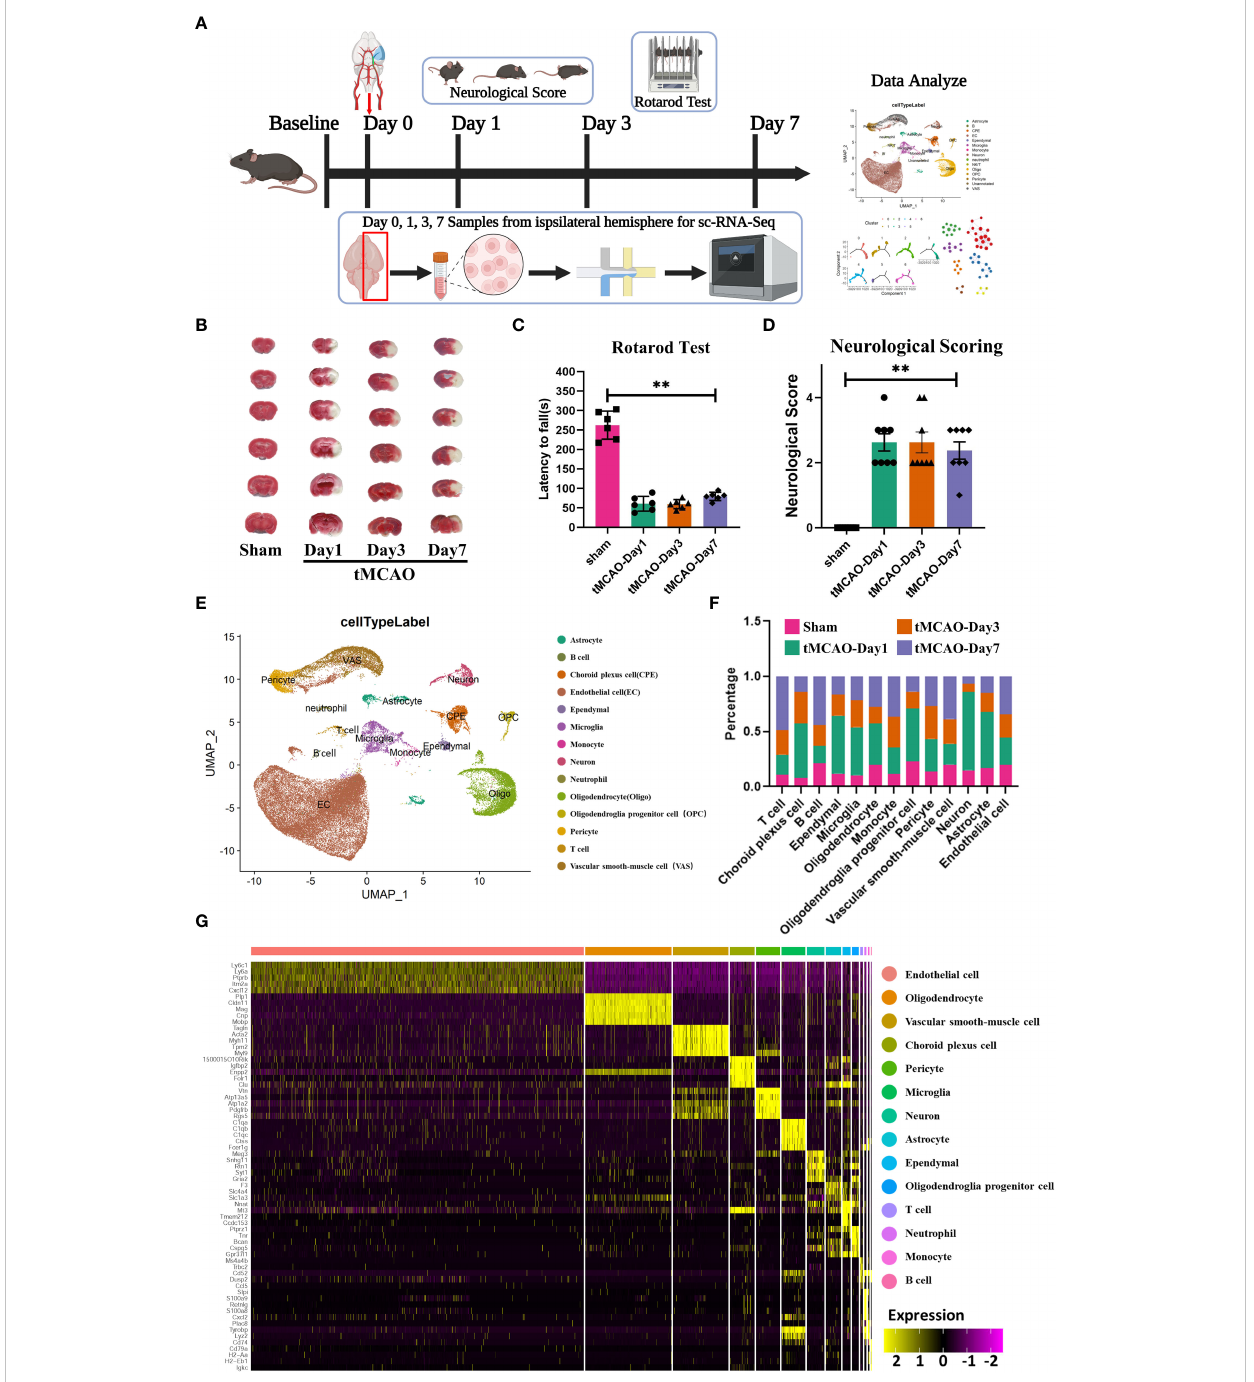
FIGURE 1 Identi fi cation of major brain cell types after tMCAO. (A) Flow chart of the experiment. (B) TTC staining of mouse brain sections after tMCAO. (C) Rotarod test and (D) Neurological Score after tMCAO. **: p < 0.001 (two-way analysis of variance followed by Dunnett's multiple comparisons tests) (E) UMAP graph of single-cell RNA sequencing subpopulations of the brain sample after tMCAO or sham. (F) Cell population ratios at each time point. (G) Heatmap of top 5 genes for each cell